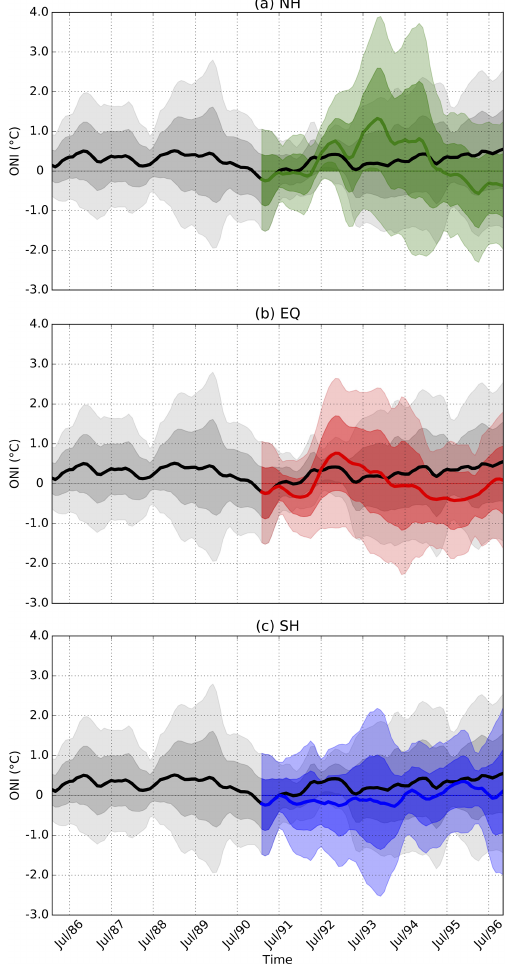
Figure 12. Time series of Oceanic Niño Index ( ◦ C) anomaly for the NH (a) , EQ (b) and SH (c) volcanic eruption cases. The black and relative solid color lines are the ensemble member means of the con- trol run and the eruption cases. The dark and light grey and relative heavy and light color shades represent 1 and 2 standard deviation of the control runs and the eruption